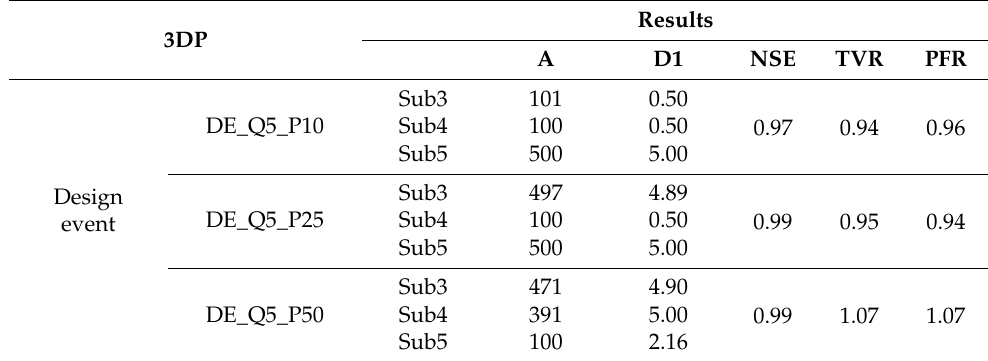
Table A3. The results of the 3DP scenario, which includes three types of a detention pond.